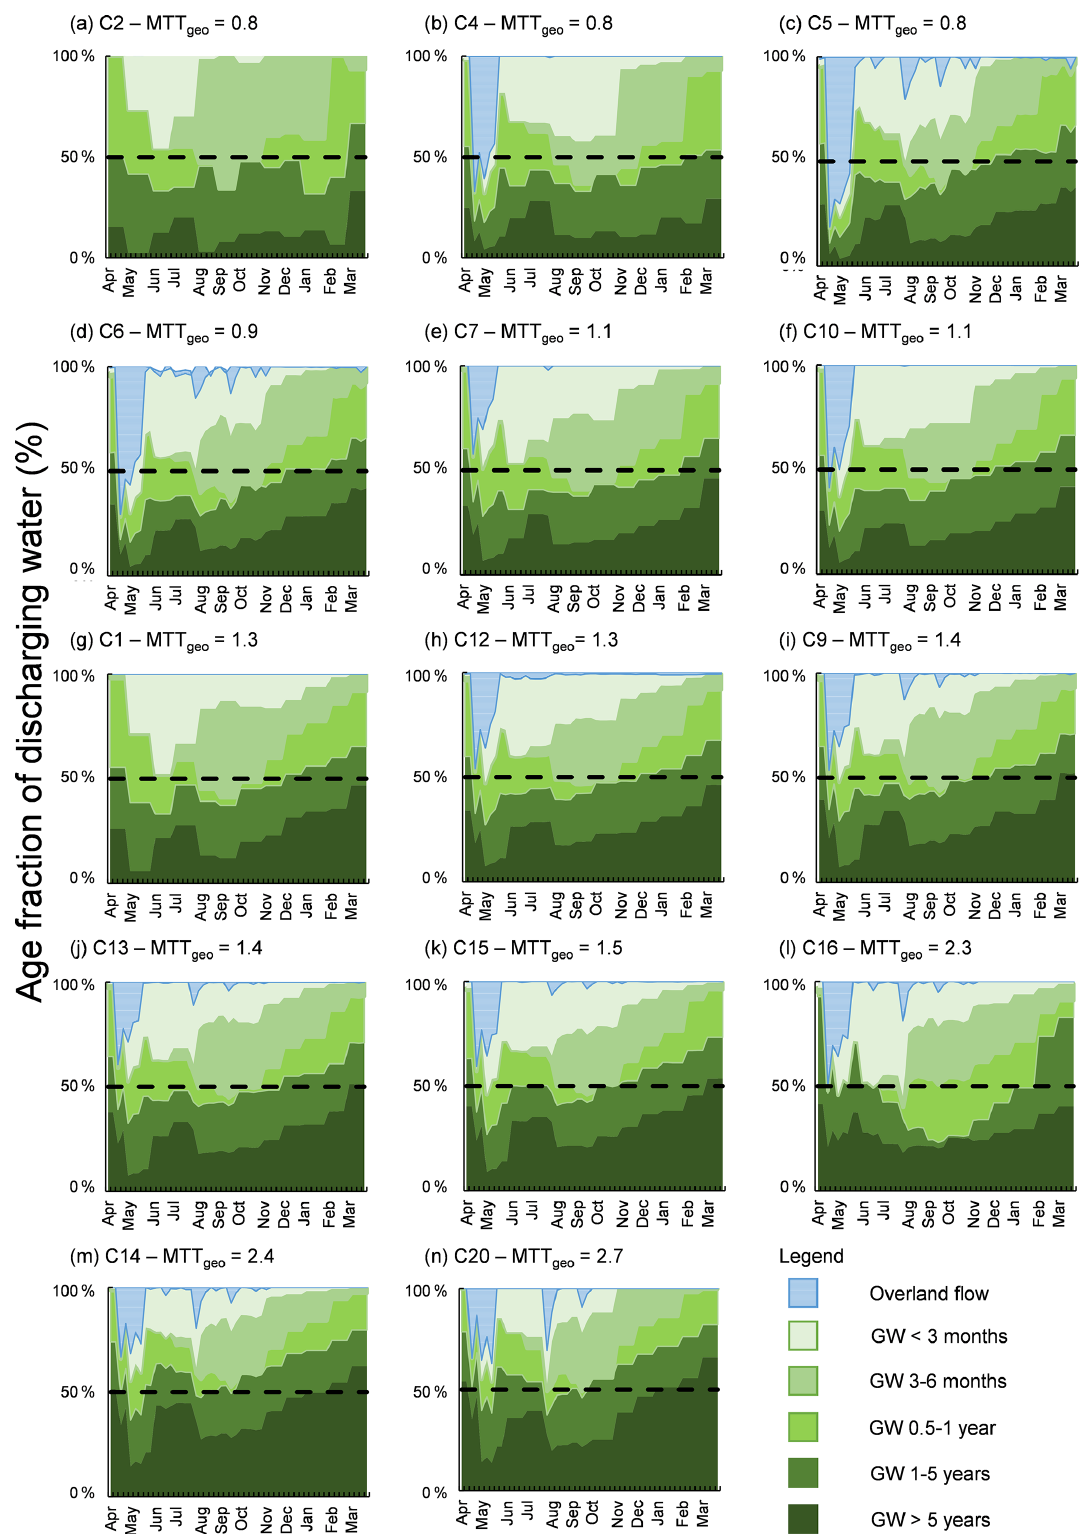
Figure A1. Travel time fraction of water discharging to the streams of Krycklan, in increasing annual geometric mean travel time, MTT geo (a–n) . The black vertical line shows the 50% mark for visual aid. All charts begin in spring (late March/early April) and end in winter (early